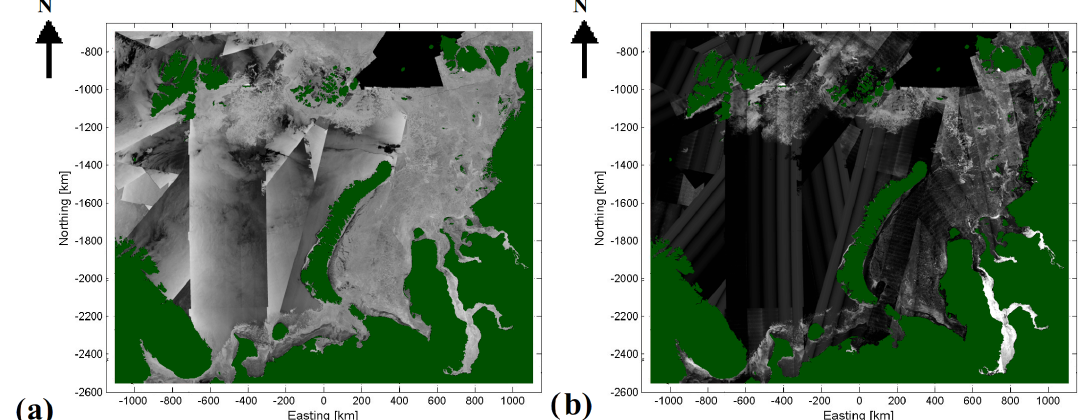
Figure 2. SAR mosaics of 8 March 2016: HH mosaic (a) and HV mosaic (b) . The land areas appear as green and areas of no data as